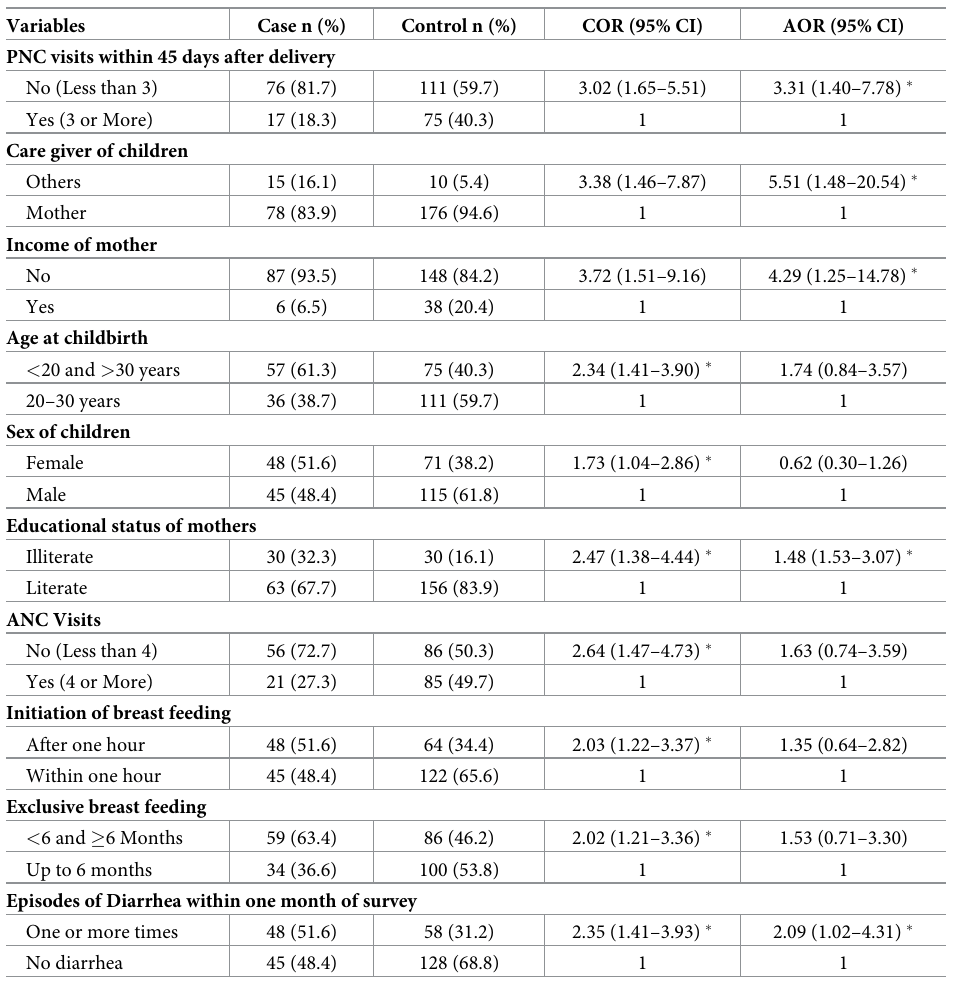
Table 3. Factors Associated with underweight among under 5